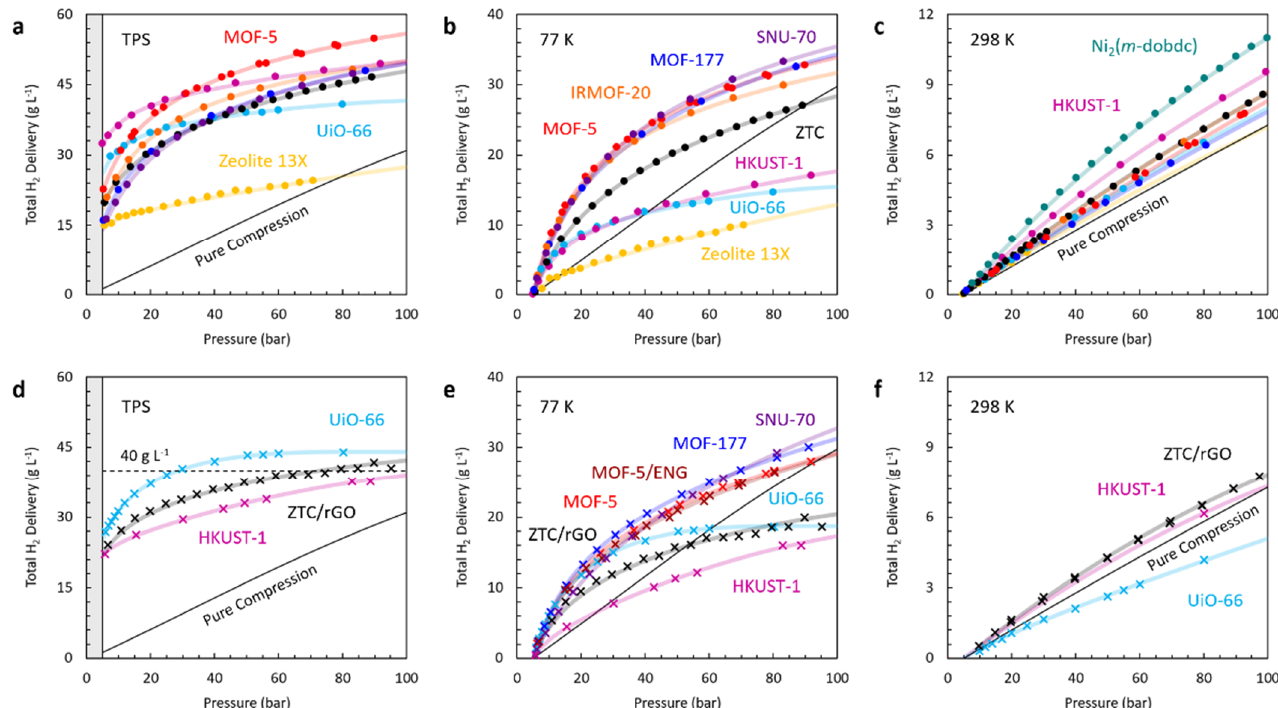
Figure 6. Total deliverable H 2 adsorption uptake on ( a , b ) benchmark crystals and ( d – f ) benchmark pellets/monoliths under ( a , d ) 5–100 bar TPS between 298–77 K ( b , e ) 5–100 bar PS at 77 K, or ( c , f ) 5–100 bar PS at 298 K. Excess H 2 adsorption data were obtained from the same references as in Figure 5 (see Supplementary Materials). The crystalline assumption was employed for all crystals ( a – c ), the skeletal assumption for all pellets ( d – f ).